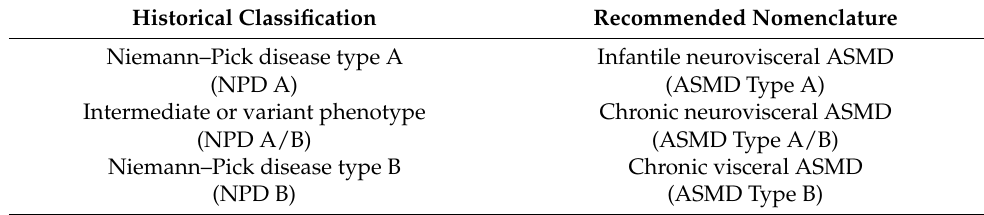
Table 1. Nomenclature for ASMD, adapted from [7].